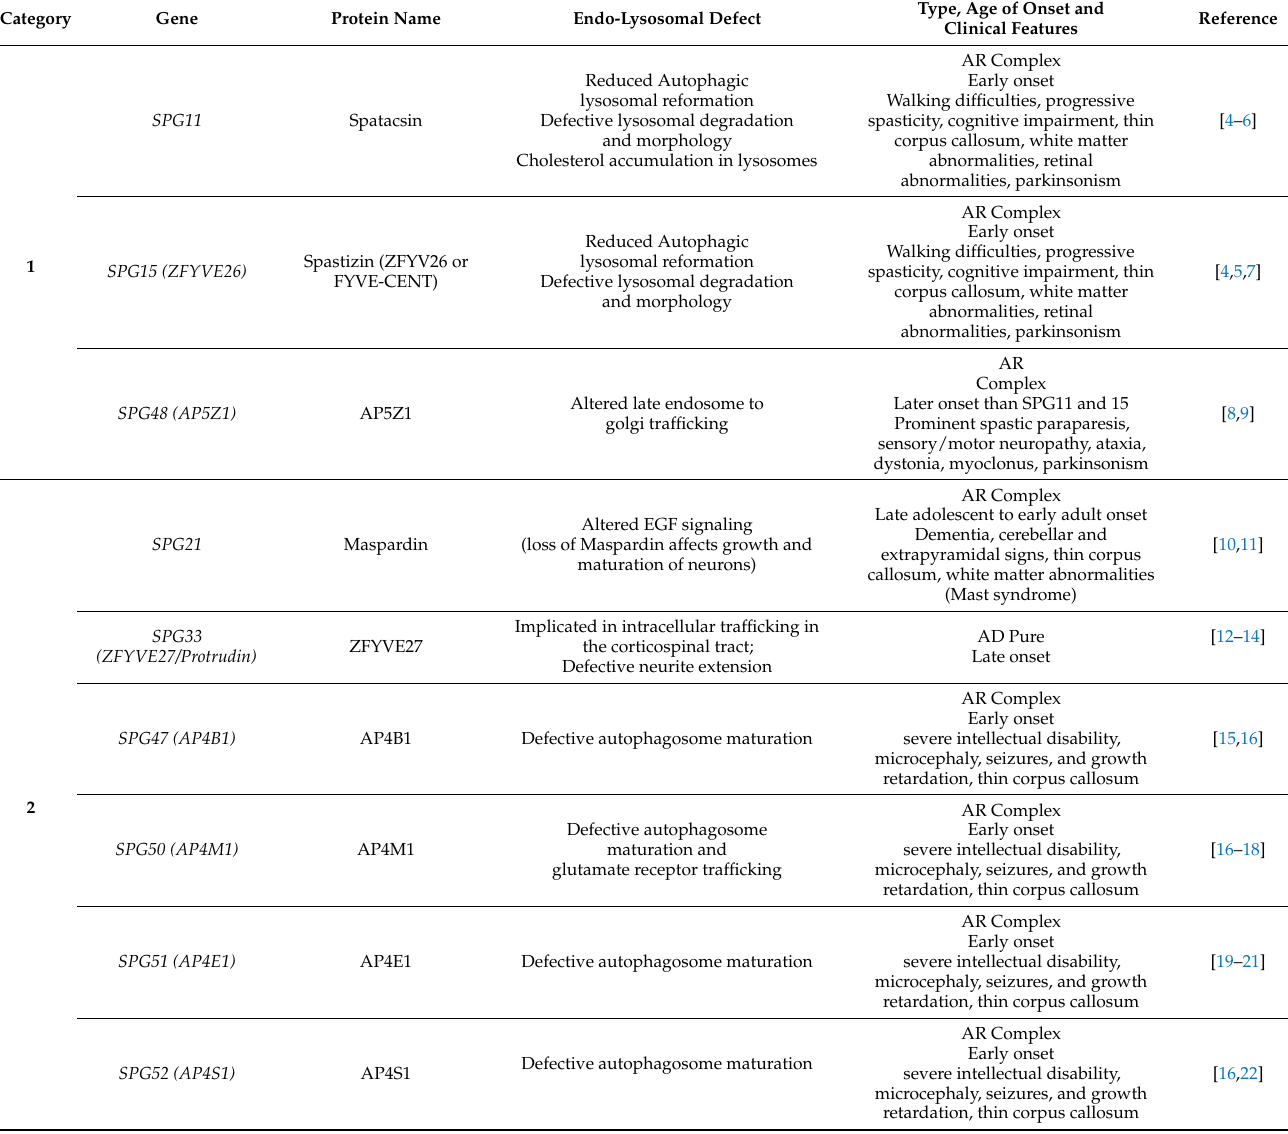
Table 1. HSP genes, categorized by function